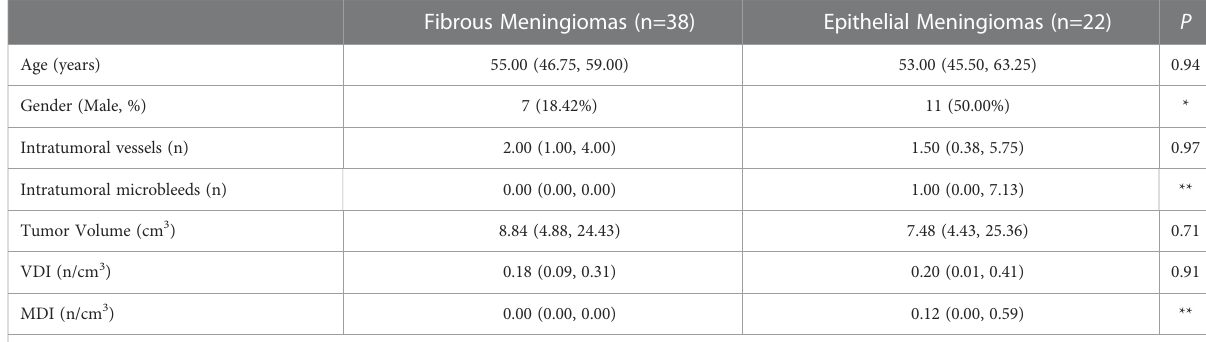
TABLE 3 Comparison of CE-T 1 WI FSBB features between fi brous meningiomas and epithelial